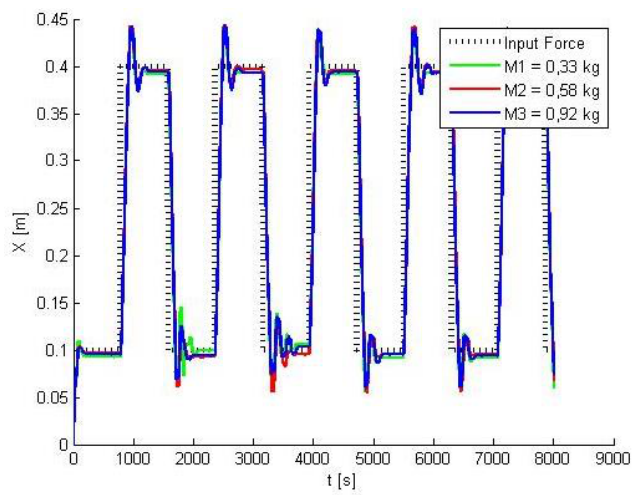
Fig. 7. Anti-swing 5DOF PI regulator X -axis position simulation results.